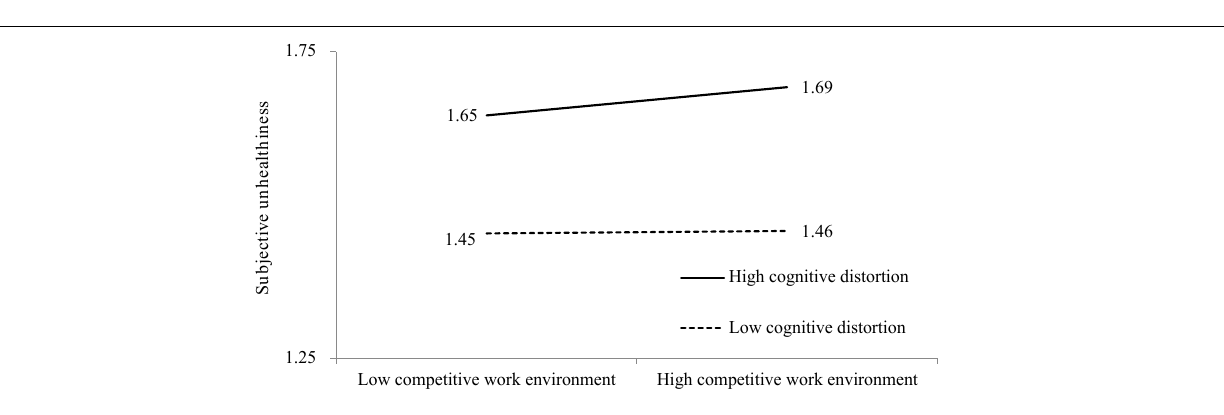
FIGURE 3 | The moderating effect of cognitive distortions on the relationship between competitive work environment and subjective